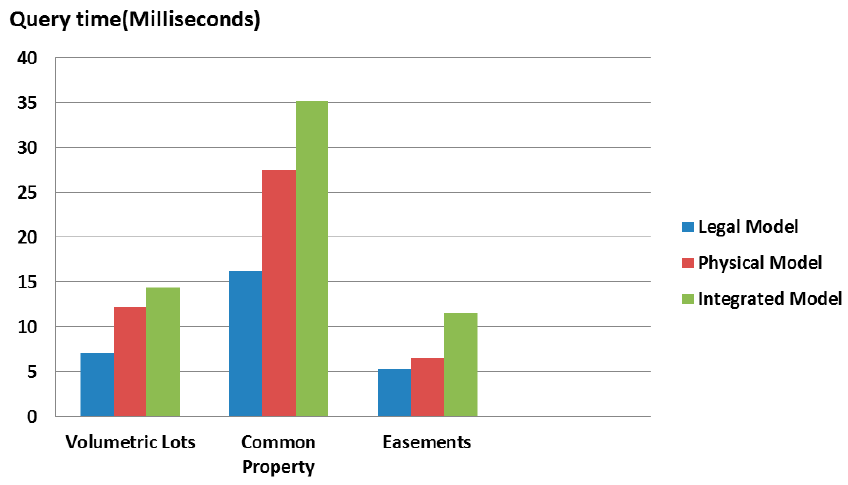
Figure 10. Measured average time for executing semantic queries in BIM models.